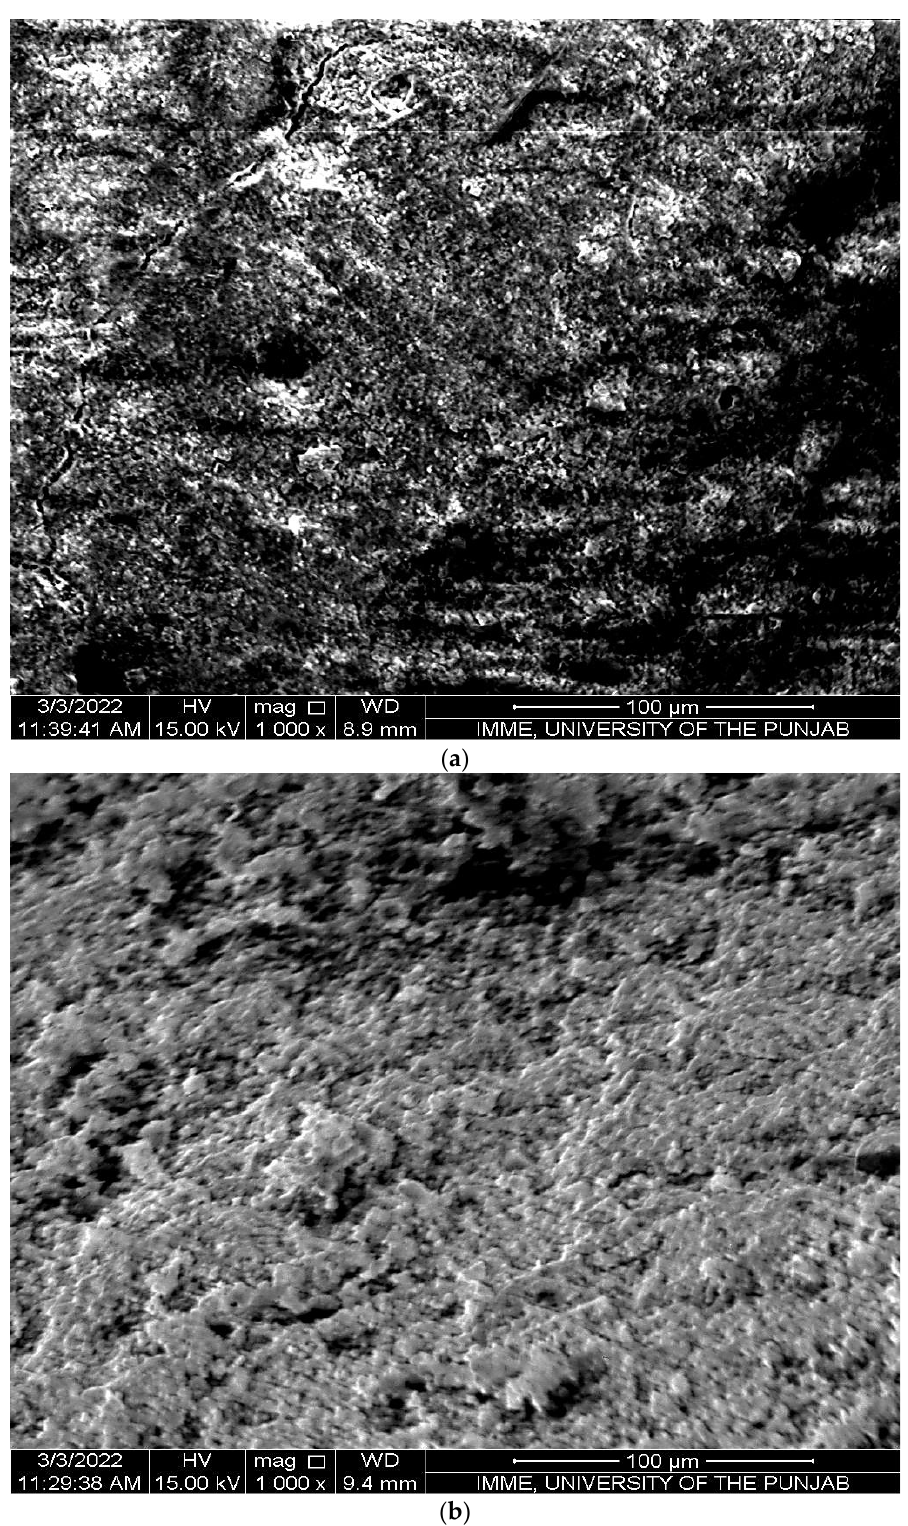
Figure 2. SEM images of ( a ) Co-Zeotype 3A and ( b ) Zeotype 3A. It is pertinent to mention here that in the current investigation we did not synthesize the zeolite, and the obtained zeolite was deposited with Co and confirmed with EDS.